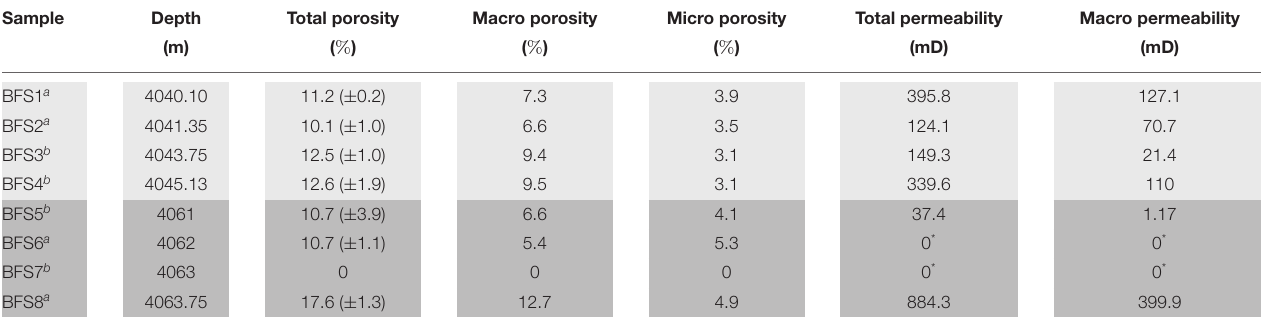
TABLE 1 | Summary of sample data used in this study, including sample name, depth interval, total porosity, macro and microporosity, permeability, associated well and voxel resolution. Sample